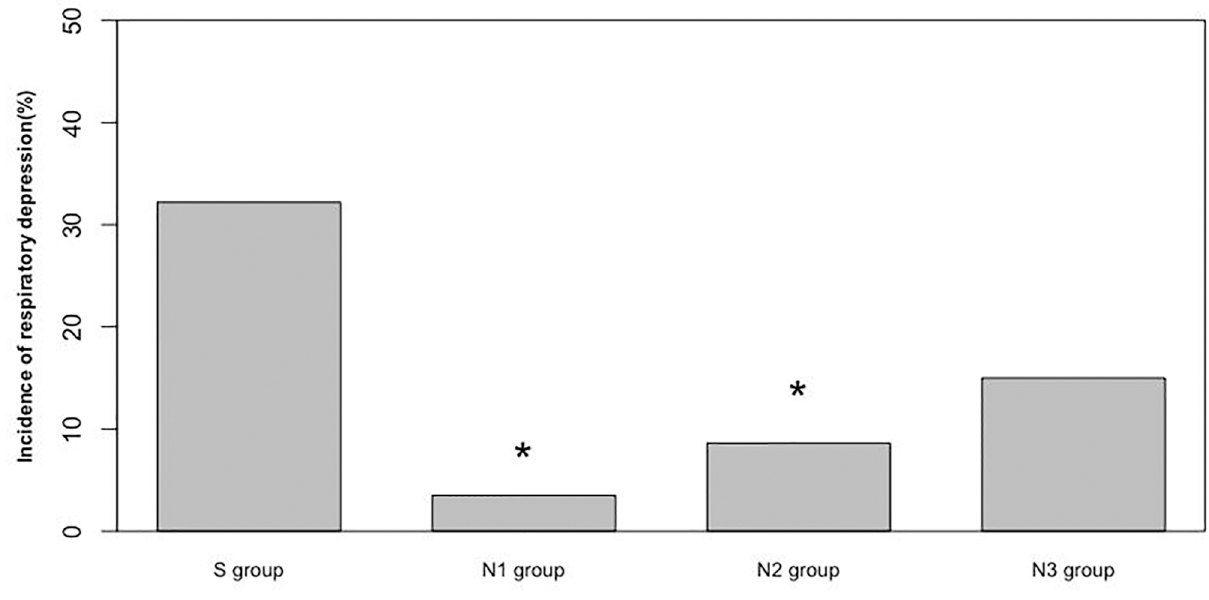
Fig 2. Incidence of respiratory depression. * Significantly lower RD than group S.